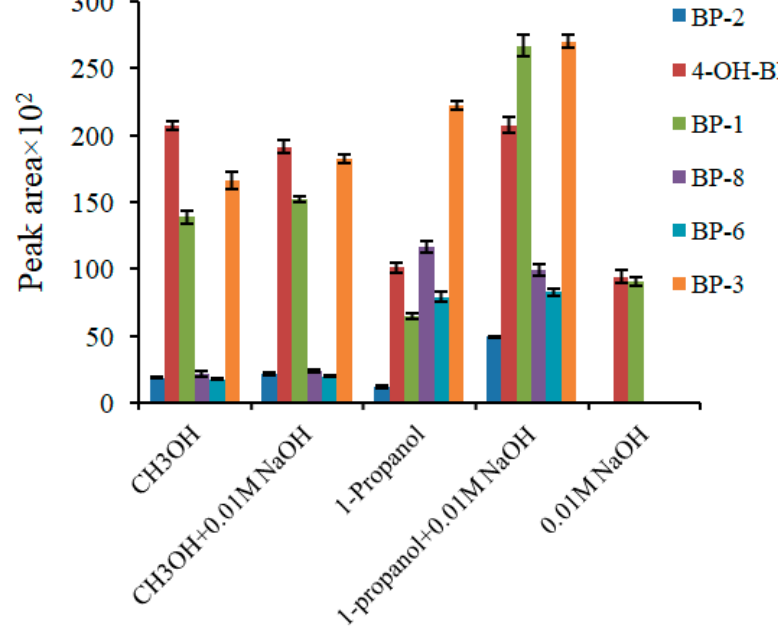
Figure 4. The effect of the elution solvent type on the efficiency of extraction. Extraction conditions: Sorbent, terephthaloyl nylon composite treated by sodium dodecyl sulfate (SDS); sample volume, 10